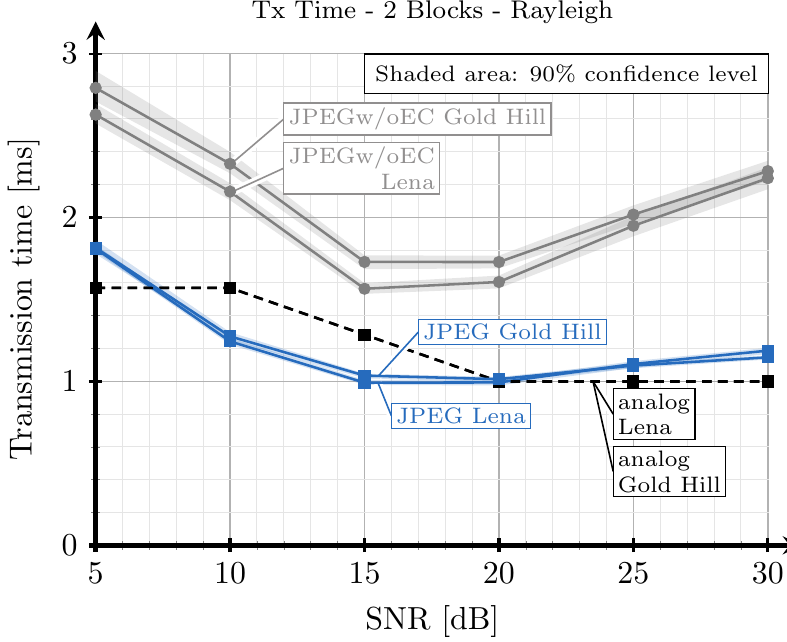
Figure 10. Transmission time vs. SNR for two blocks and Rayleigh